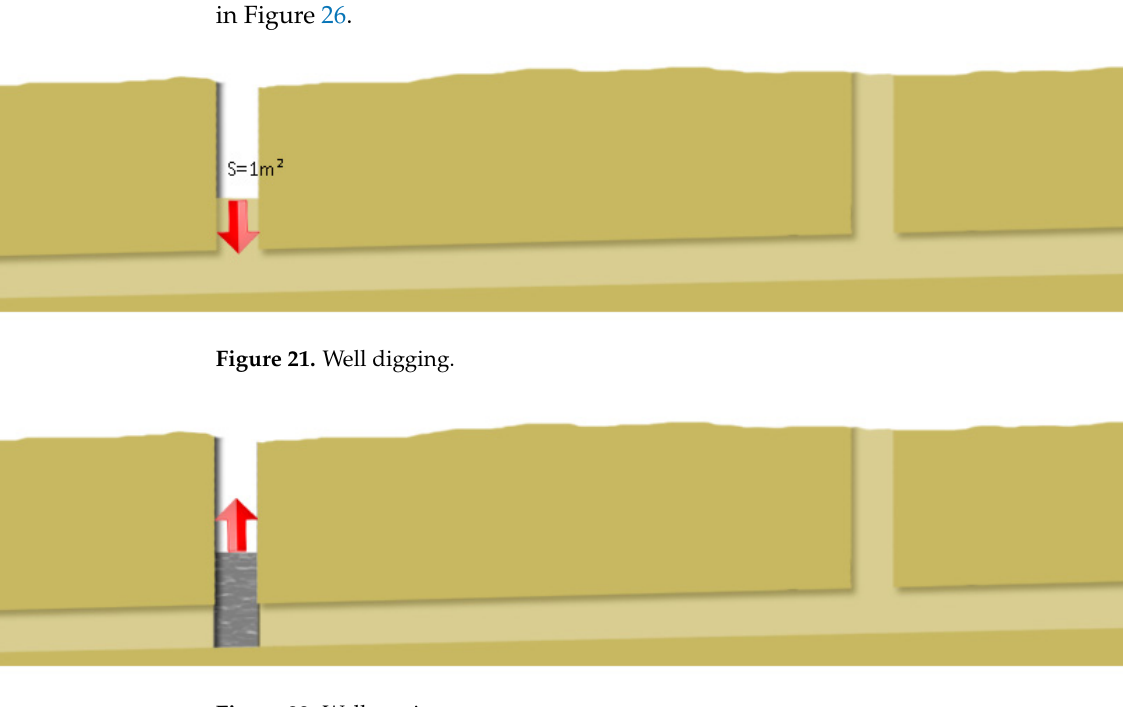
Figure 22. Well coating. Figure 22. Well